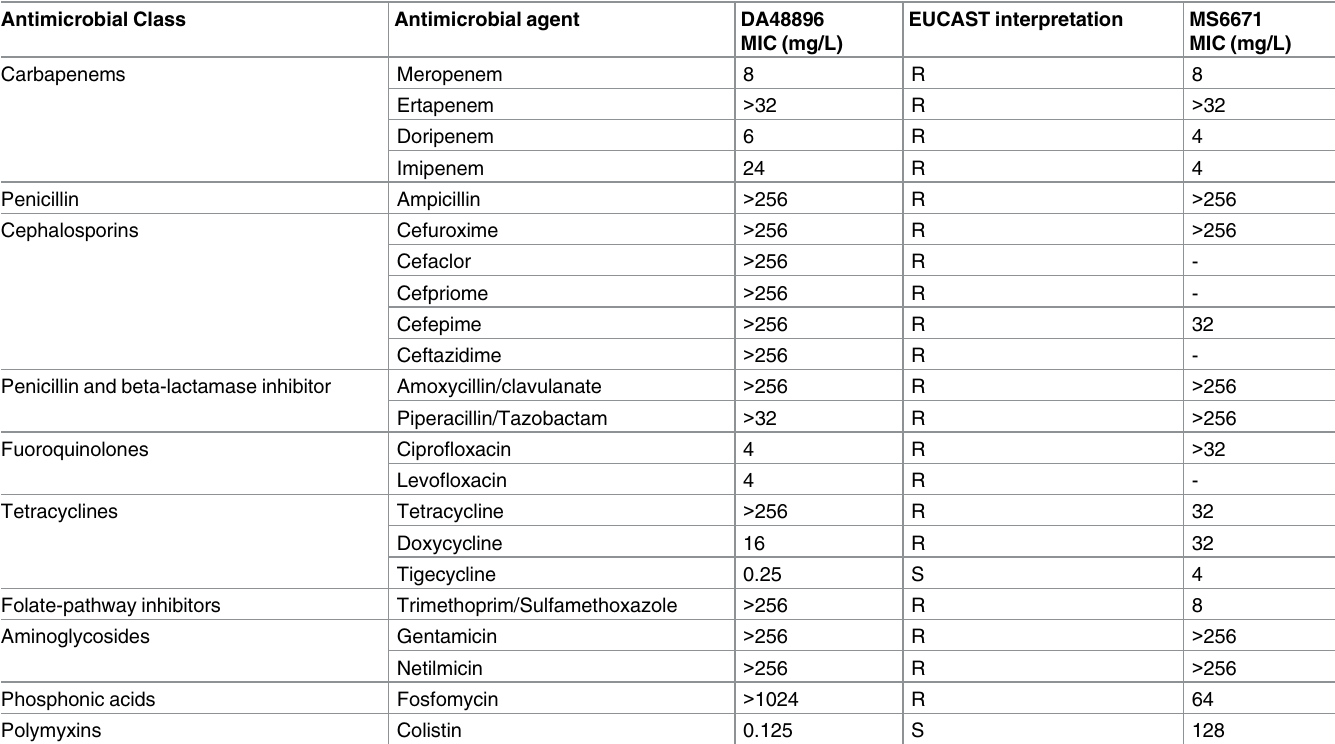
Table 1. MICs against routinely used antibiotics. Antimicrobial